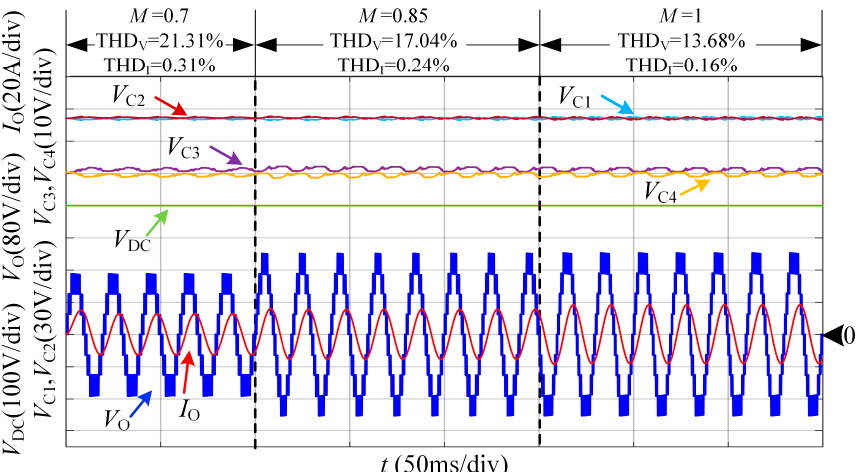
Figure 10. Simulation results under different modulation degree M.